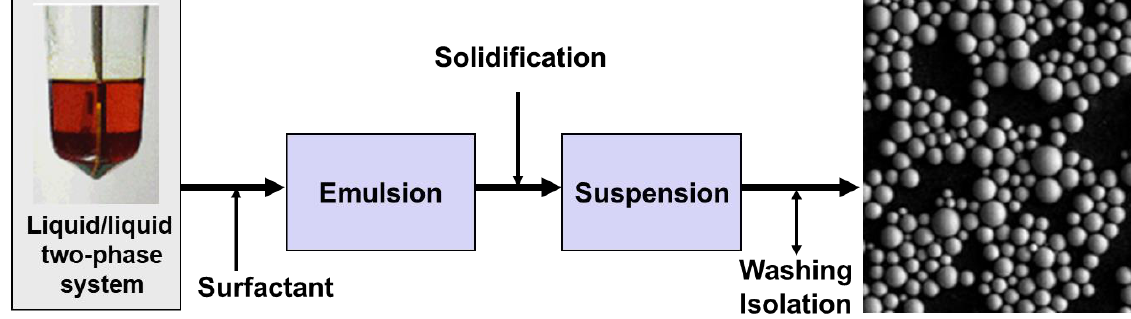
Figure 7. Process scheme of the ‘Sirius’ emulsion process for ZN catalyst production.